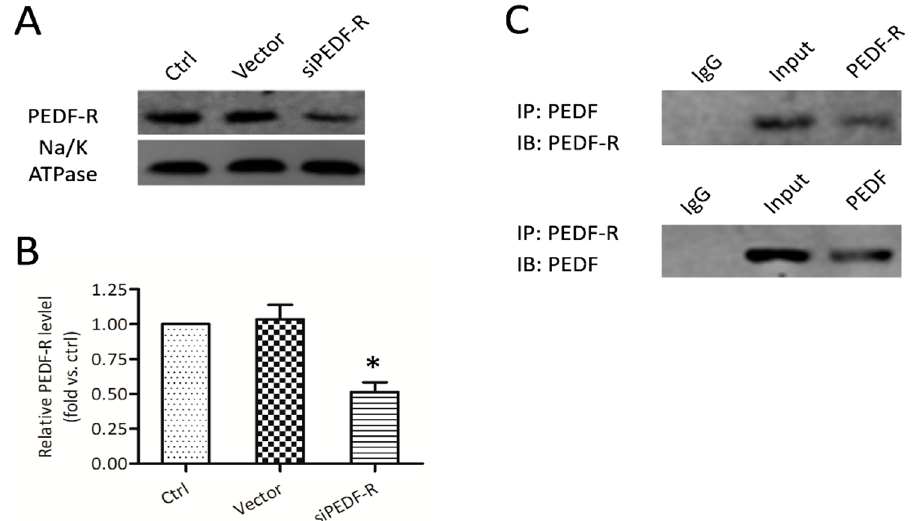
Figure 3. Expression and interaction of PEDF and PEDF receptor (PEDF-R) in MC3T3-E1 cells. RNA interference assays were utilized to knockdown PEDF-R. ( A ) PEDF-R expression detected from membrane protein extracts of MC3T3-E1 pre-osteoblasts by Western blot; ( B ) Results were presented as fold induction, relative to control. ( n = 4, * p < 0.05); ( C ) After 12 h treatment with recombinant PEDF (rPEDF) (10 nmol/L), membrane protein extracts of MC3T3-E1 cells were immunoprecipitated with PEDF or PEDF-R antibodies, the precipitates were detected using PEDF or PEDF-R antibodies.